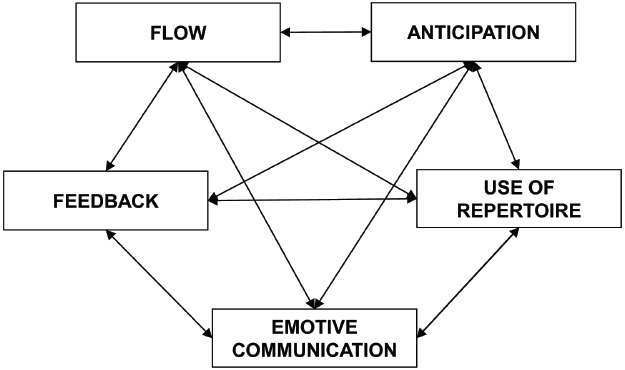
The dimensions of musical improvisation by Biasutti and Frezza (2009).